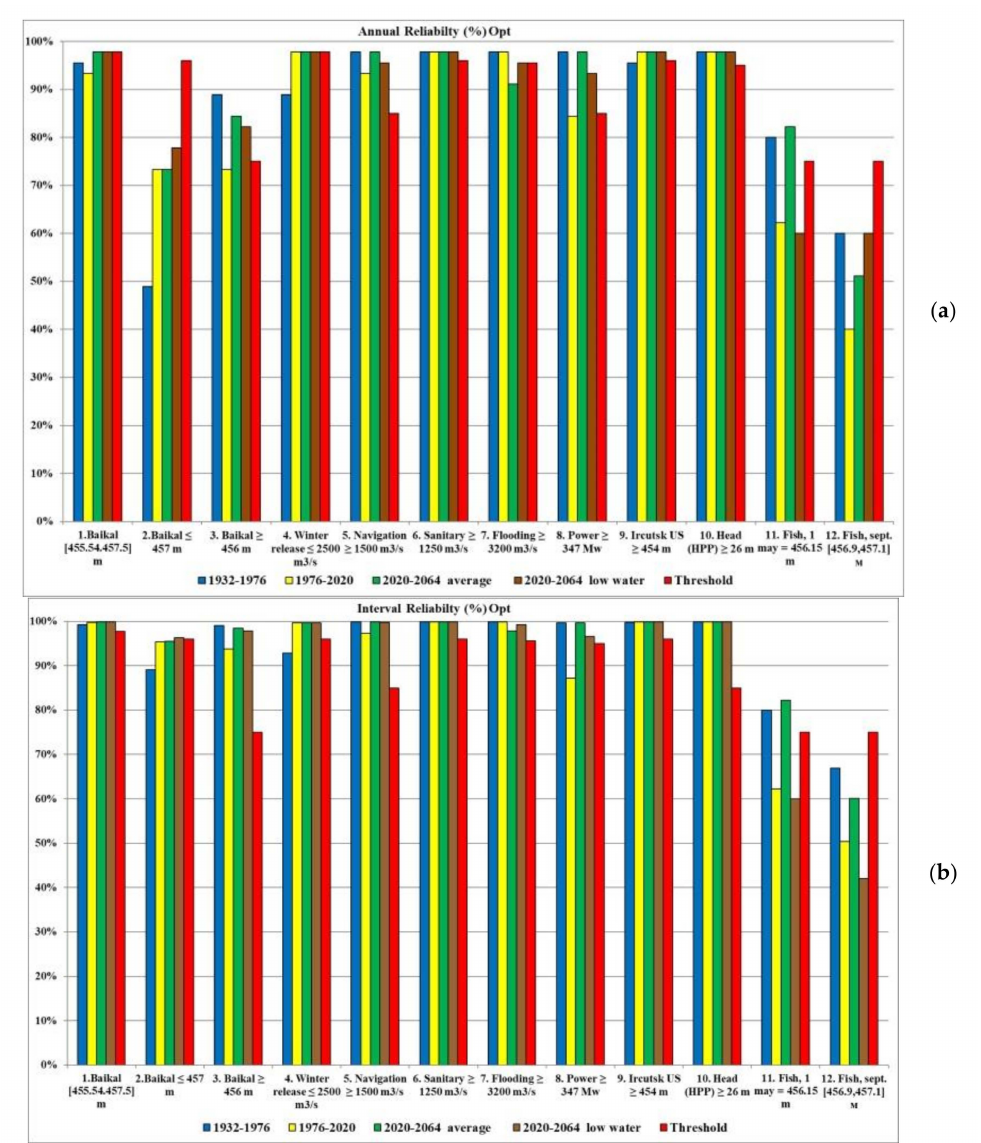
Figure 14. Annual ( a ) and interval ( b ) indicators of reliability when WRC use optimization for different time